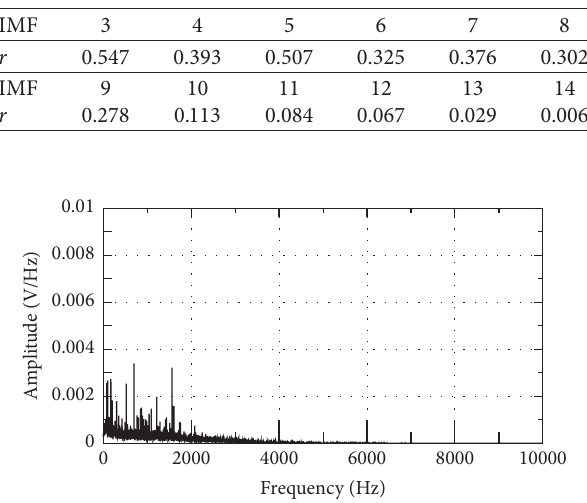
Figure 17: Frequency spectrum diagram of swash plate wear signal after noise